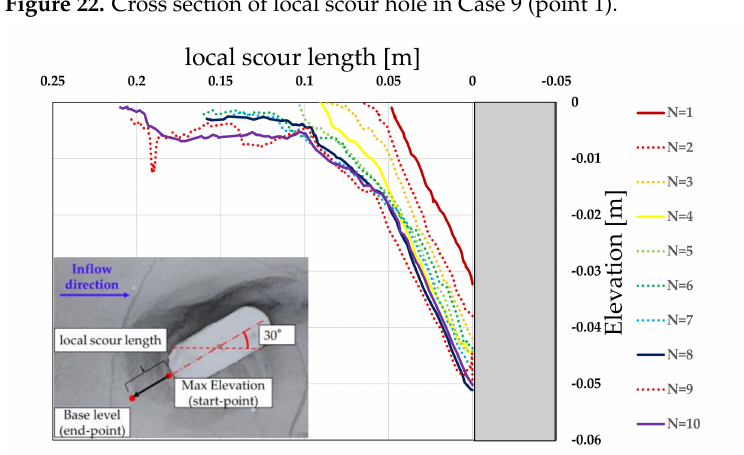
Figure 22. Cross section of local scour hole in Case 9 (point 1).